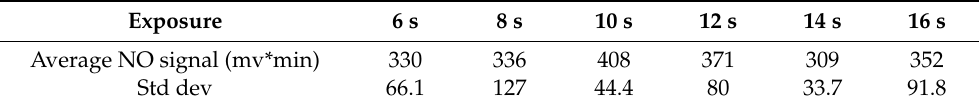
Table 1. UV experiment summary displaying average NO release.